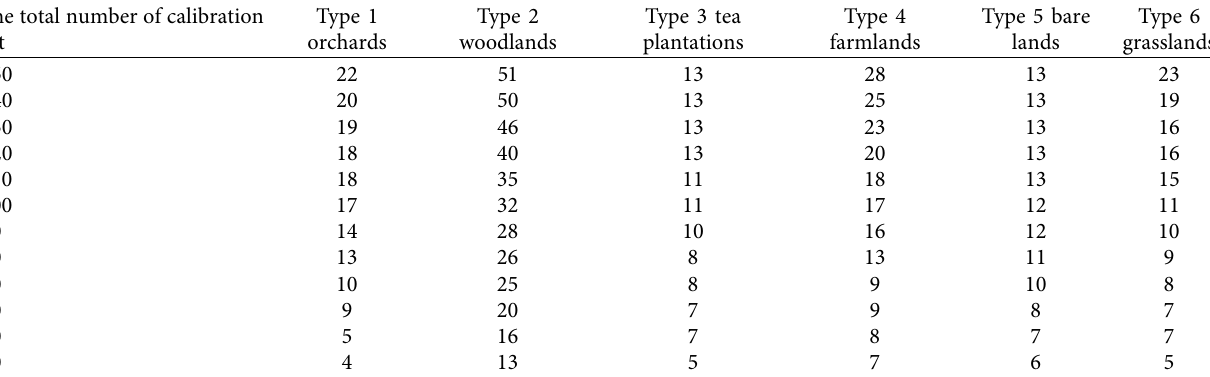
Figure 3: The convolutional neural network process for soil classification. C is the convolutional layer, and P is the pooling Table 3: The number of the calibration set samples by Kennard–Stone algorithm.